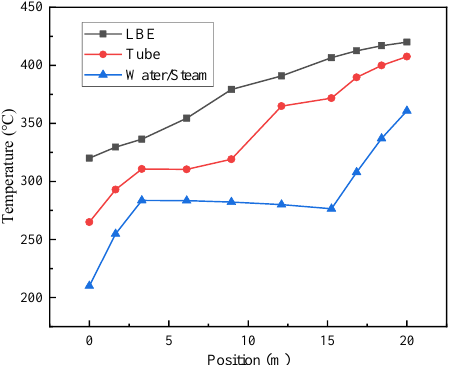
Figure 2. Temperature distribution of OTSG in this work.